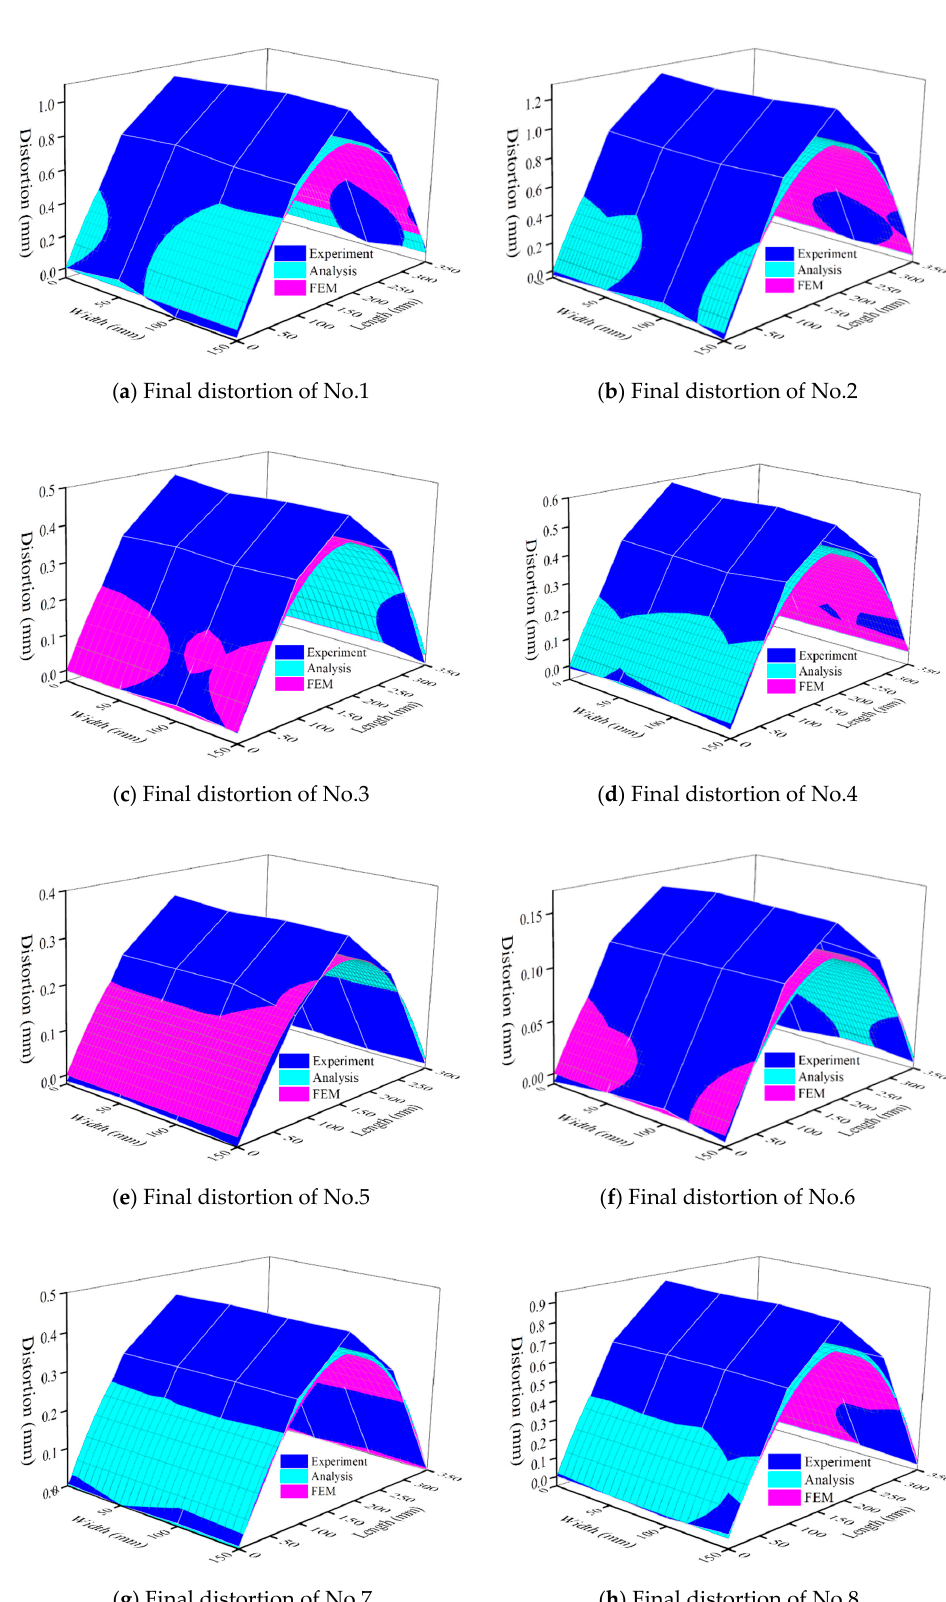
Figure 8. The final distortion of all the specimens.